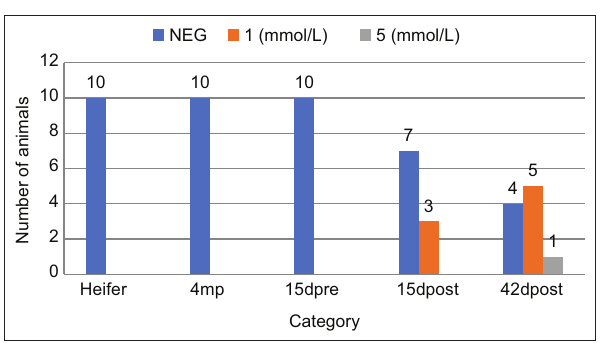
Figure-2: Detection of acetoacetate in urine of Table-3: Results for ketosis in blood and urine samples from the 50 animals sampled. Results of blood test